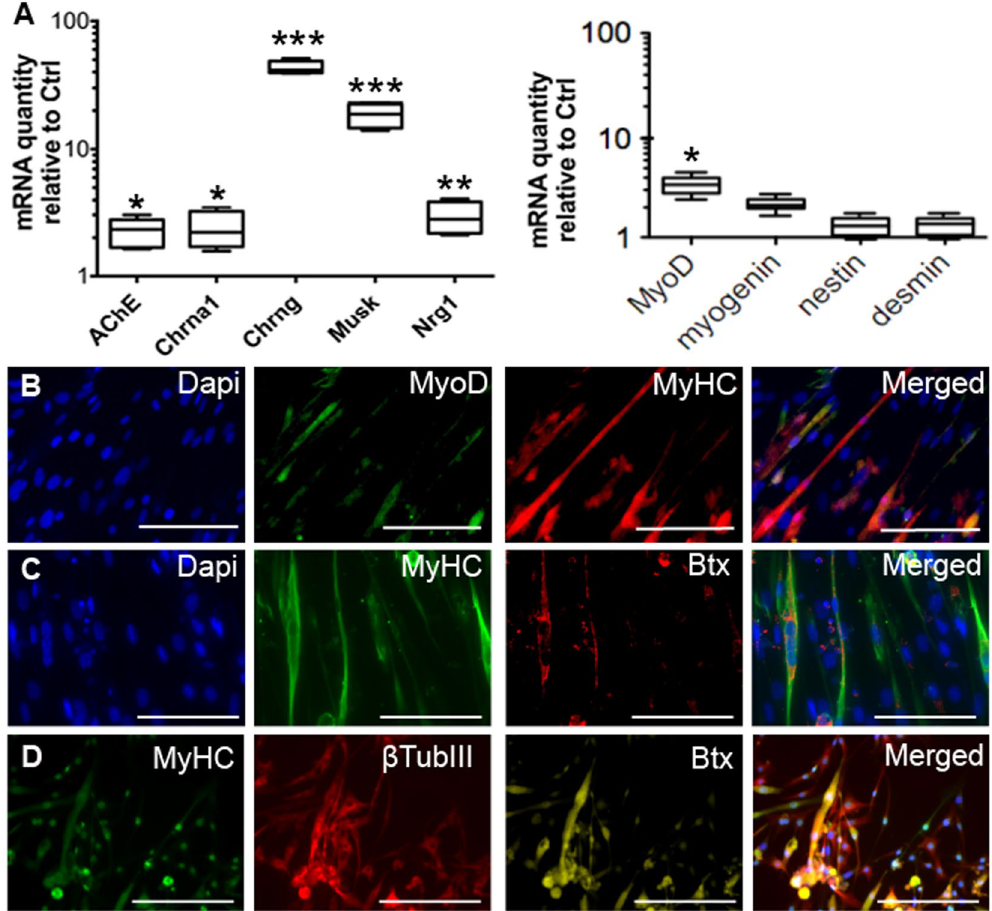
Figure 3. Myogenic differentiation of iMuSCs and NMJ formation. ( A ) Whisker plots summarize the expression of NMJ-related genes as well as the myogenic genes within the neurosepheres in culture, analyzed by qPCR. ( B ) After the neurospheres were replaced into monolayer culture in MD Medium, their recovered their myogenic ability, formed myotube-like structures, and begun expression of myogenic protein MyoD (green, B ), MyHC (Red, B; green, C , D ). The attached neurospheres also formed neuron-like structures expressing β -Tubulin III (red, D ). The presence of NMJs was shown by Btx staining (red, C ; yellow, D ). Nuclei were stained with Dapi. Scale bar = 100 µ